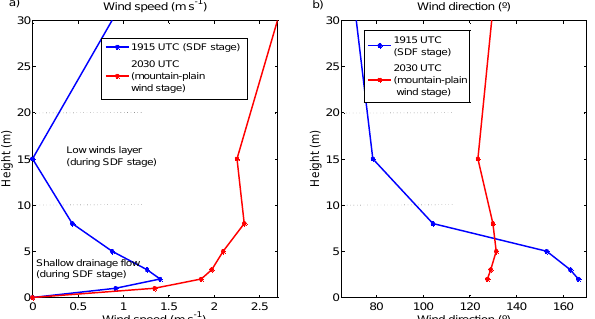
Figure 3. Wind speed (a) (ms − 1 ) and wind direction (b) ( ◦ ) verti- cal profiles during shallow drainage flow (SDF) stage at 19:15UTC (blue line) and during mountain-plain wind stage at 20:30UTC (red line). Measurements from the divergence site and 60m tower site instruments.